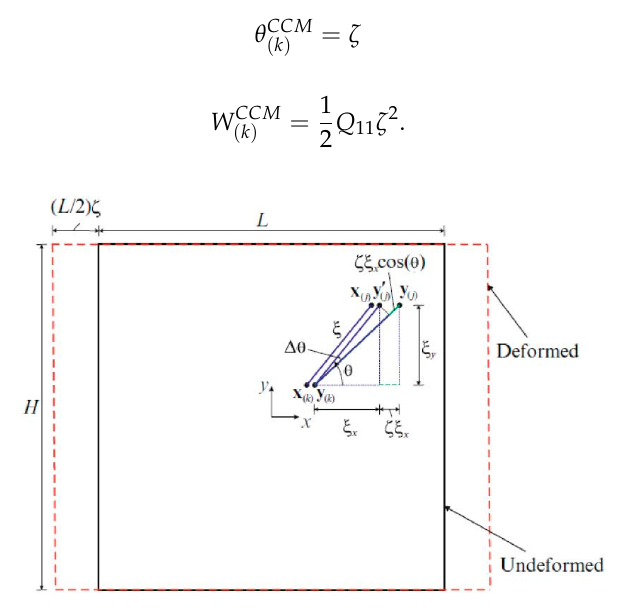
Figure 4. Uniaxial loading condition in crystal orientation direction, x .